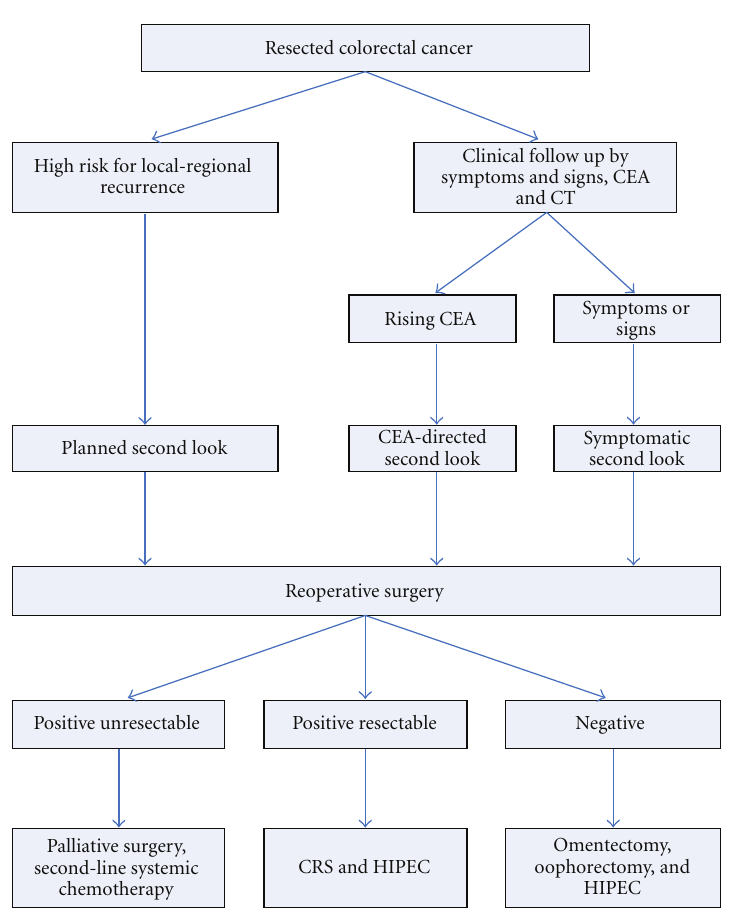
Figure 2: Algorithm for a planned second look in patients at high risk for local-regional cancer recurrence. CEA: carcinoembryonic antigen; CRS: cytoreductive surgery; HIPEC: hyperthermic intraperitoneal